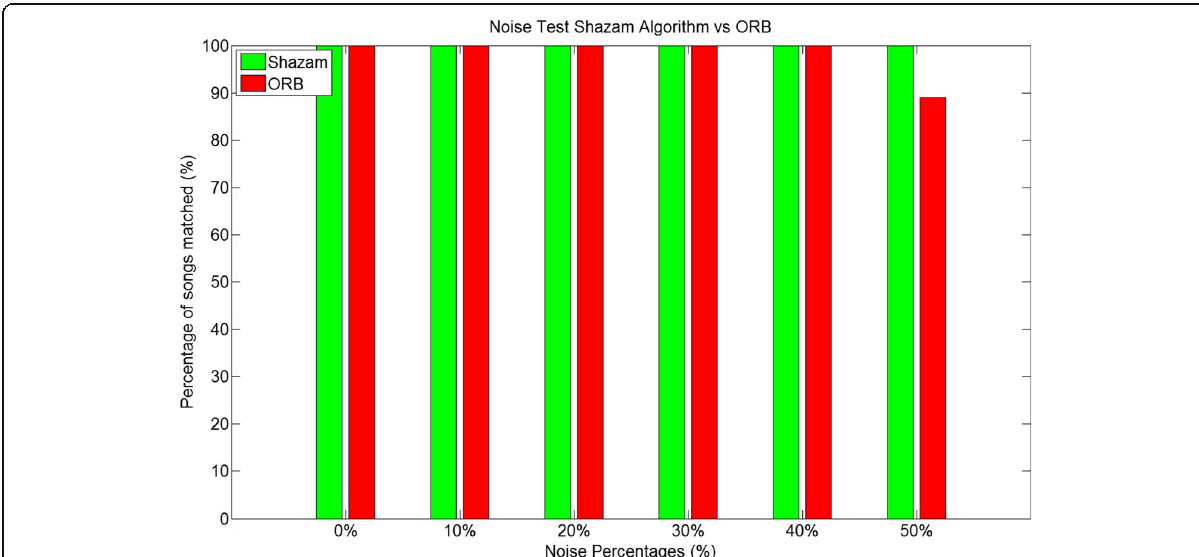
Fig. 6 Noise test for robustness (Shazam vs ORB). In this figure, the experiment involved testing the ability to accurately identify the audio sample when it is subjected to the addition of noise. In the real world, this is a common case. Additive white Gaussian noise was added which would be used to simulate background noise. The similar test setup was done where a 20-s clip was taken from each song in the database, and the various degrees of noise were added to each sample and then tested for each system. It was seen that the Shazam algorithm was very robust to the noise as seen in the results. This would be due to the peaks being acquired using the spectrogram data in the audio fingerprinting extraction process. The peaks obtained will be more likely to survive the effects of noise as the song ’ s frequencies (from the audio sample) would have a higher amplitude when compared to the amplitude of frequencies of the noise. It was seen that the Shazam ’ s algorithm performed better in comparison to the ORB prototype although the